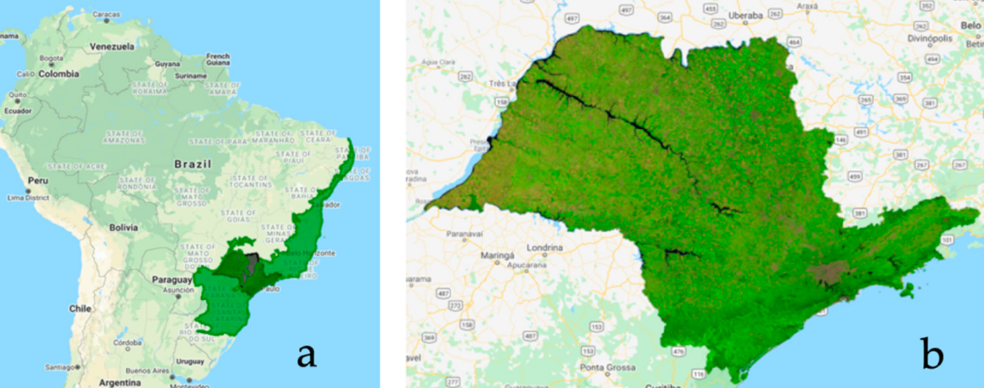
Figure 1. Overview of the study area: ( a ) The span of the Atlantic Rainforest, which is located along coastal and inland regions, and has coverage in 17 states, from Cear á to Rio Grande do Sul, including mountainous regions and plateaus; ( b ) Region of S ã o Paulo State, which has nearly 14% forest coverage. Image from the Landsat 8 Image Mosaic from Mapbiomas Collection 5 for 2019